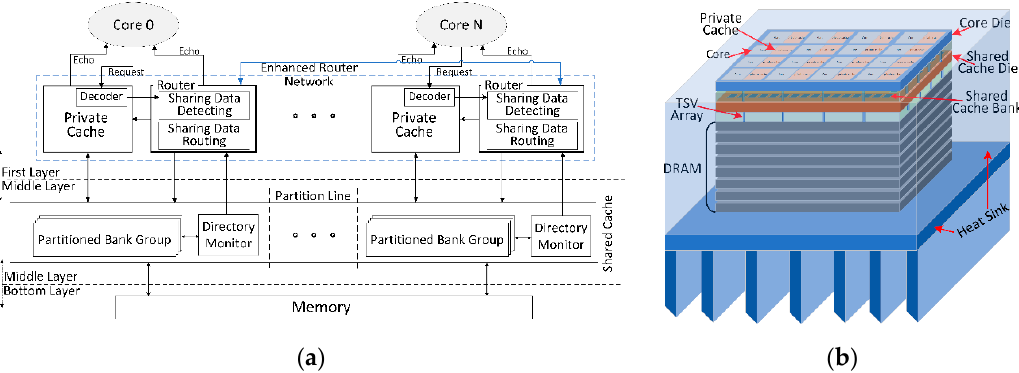
Figure 2. Proposed CMP system architecture: ( a ) Schematic diagram of enhanced router network; ( b ) an example of 3D stacked 16-core 3-layer architecture, where the chip is embedded in heat sink.